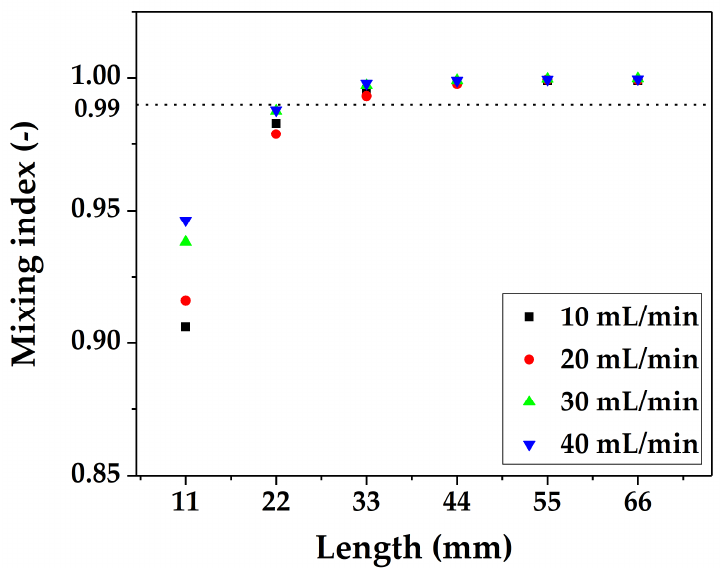
Figure 7. Variation in the mixing index with flow distance under different flow rates.